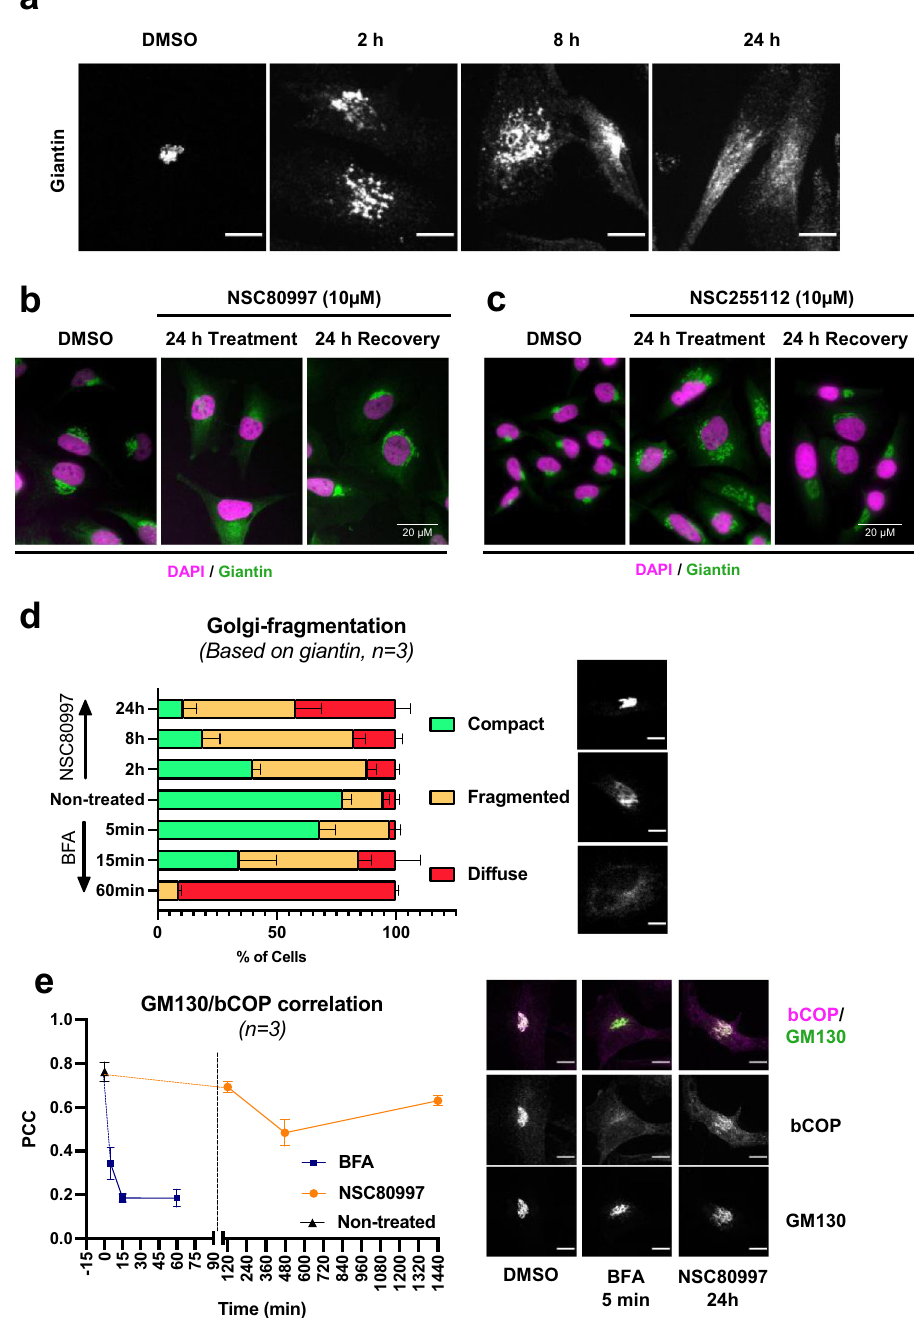
Fig. 5 | NSC80997 and NSC255112 trigger reversible Golgi fragmentation. HeLa WT cells were treated with 10 µ M NSC80997, NSC255112 or Brefeldin A and processed for immuno fl uorescence. a – c HeLa cells were imaged by confocal microscopy to reveal the morphology of the Golgi apparatus (giantin, green) and thenuclei(DAPI,magenta). a TimecourseofGolgifragmentationduringtreatment with NSC80997. Scale bars represent 10 µ m. b , c After treatment for 24h with either NSC80997 ( b ) or NSC255112 ( c ), cells were washed with fresh medium and incubated for another 24 hrs without inhibitor. Scale bar represents 20 µ m. d Bar plot shows percentage of HeLa WT cells displaying compact, fragmented or diffuse Golgi morphologies at different timepoints during treatment with